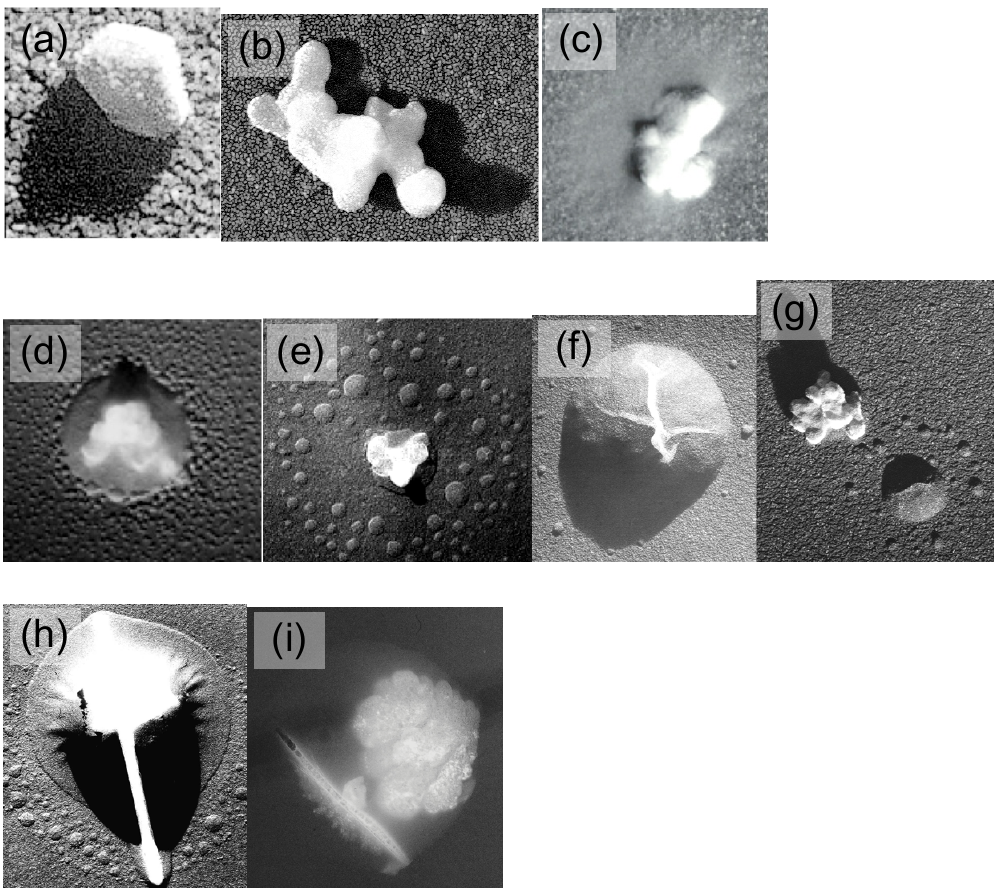
Figure 10. Examples of the changing nature of the high Arctic particles in different modal diameters: (a–c) sub-Aitken mode, (a) penta- hexagonal structure, crystalline and hydrophobic in nature assumed to be a colloidal building block of a polymer gel, (b) small polymer gel-aggregate slightly covered with hydrophilic mucus, (c) same as in b but with more mucus remaining promoting its hydrophilic properties, (d–g) Aitken to small accumulation mode, (d) particle with a high sulfuric acid content with a gel-aggregate inclusion embedded in a film of high organic content, (e) gel-aggregate with satellites, indicating the presence of organics and acids, (f) particle containing mainly ammonium sulfate and methane sulfonate, (g) external mixture of a gel-aggregate and similar particle as of (f) , and (h–i) large accumulation mode, (h) sea-salt particle with an organic content. The rod through its centre is assumed to be a bacterium. The particle has an acquired coating of sulfuric acid, (i) a gel-aggregate containing a bacterium attached to a small aggregate possibly detached from the larger one. The particles’ bubble-like shape indicates a possible recent injection to the atmosphere at the air–sea